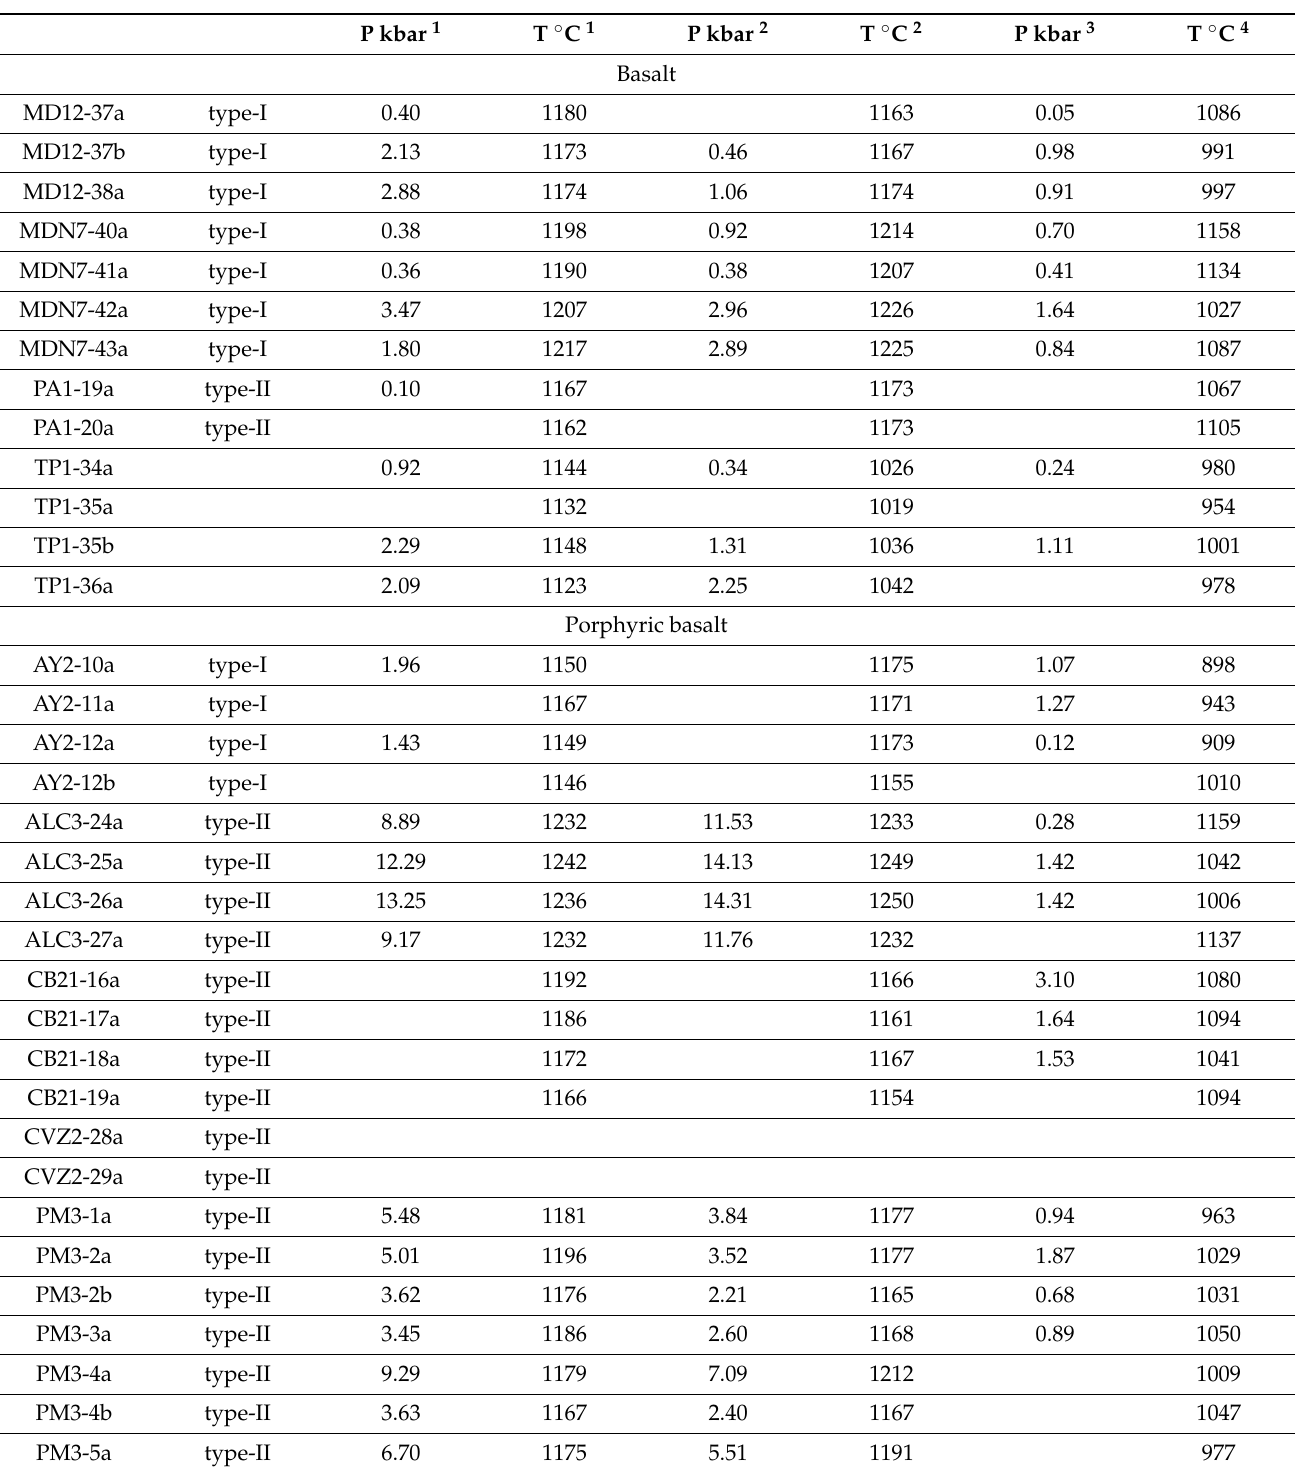
Table 3. Estimates of the crystallization conditions of clinopyroxenes from the Yüksekova Complex (E